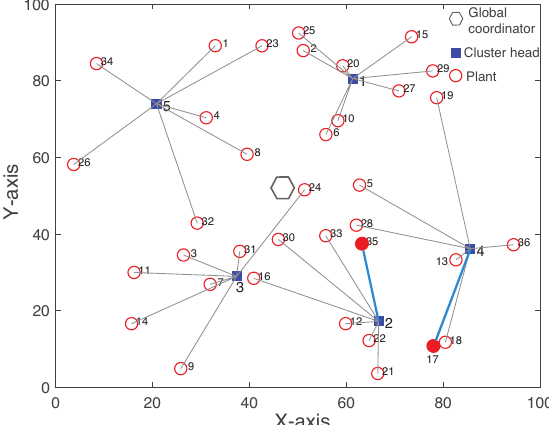
Figure 8. Reconfigured network clustering after the intra-cluster link failure between plant 35 and cluster head